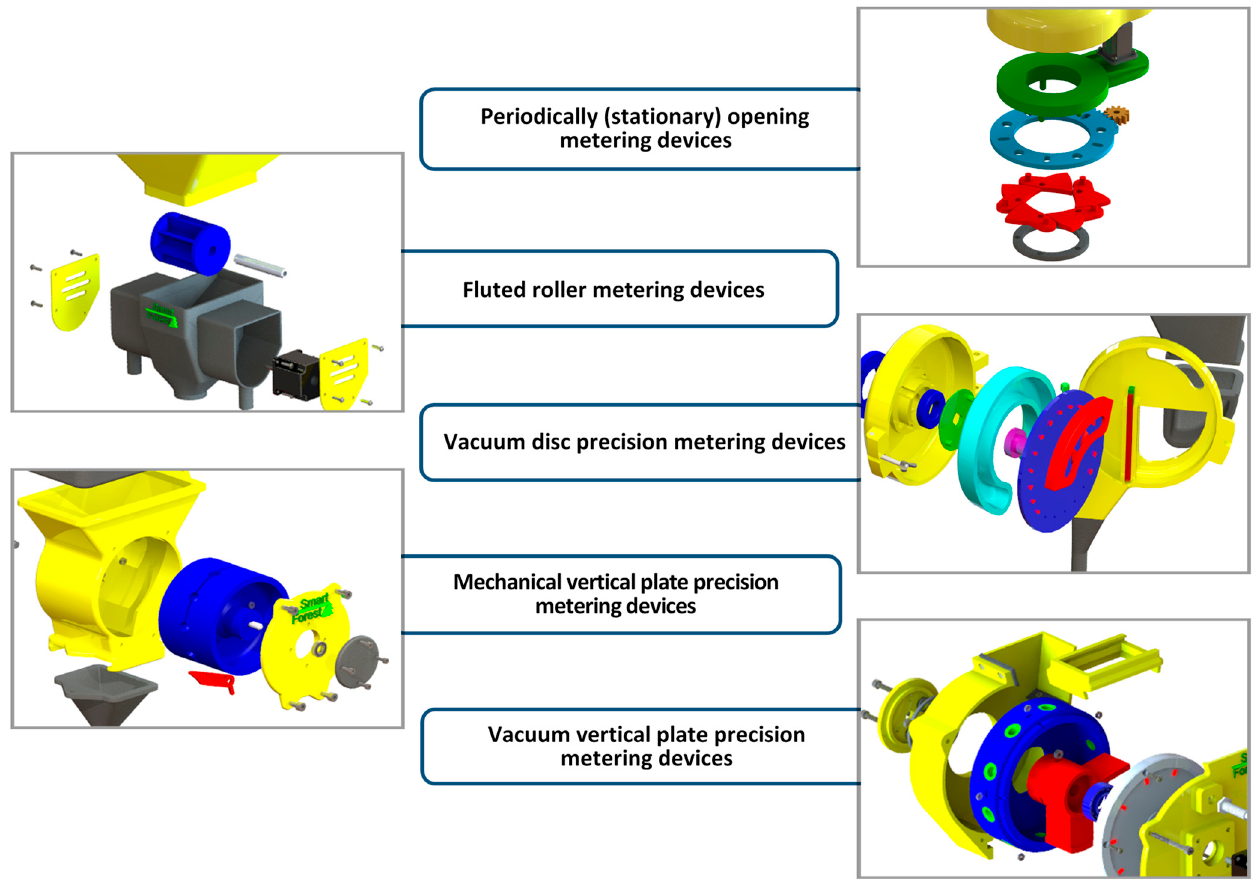
Figure 1. Metering mechanisms of sowing device.